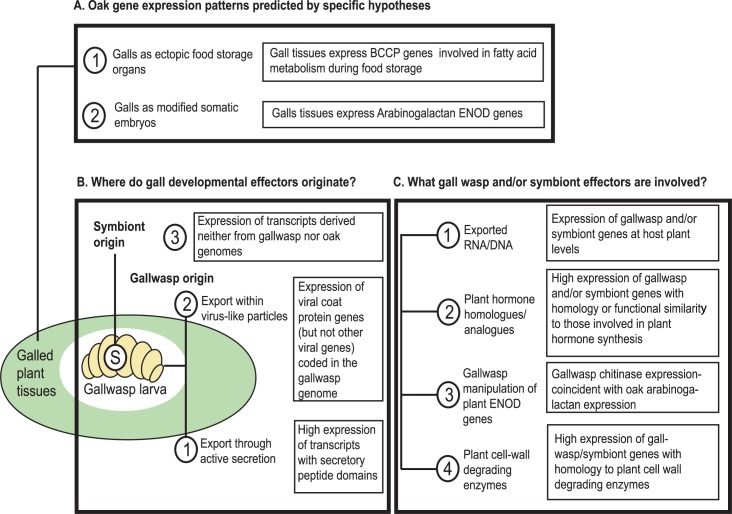
Patterns of oak, gall wasp and symbiont gene expression expected under alternative hypotheses for cynipid gall development.A. Oak gene expression patterns predicted under the ectopic food storage organ and somatic embryo hypotheses. B. Alternative hypotheses for the origin(s) and delivery of gall development effectors. C. Alternative possible effectors. In each of A-C, boxed texts summarise expectations for patterns in transcriptome data if the hypotheses are supported (see main text Introduction and Discussion for explanation). The circled ‘S’ within the gall wasp larva represents a possible internal symbiont, such as a virus or bacterium.